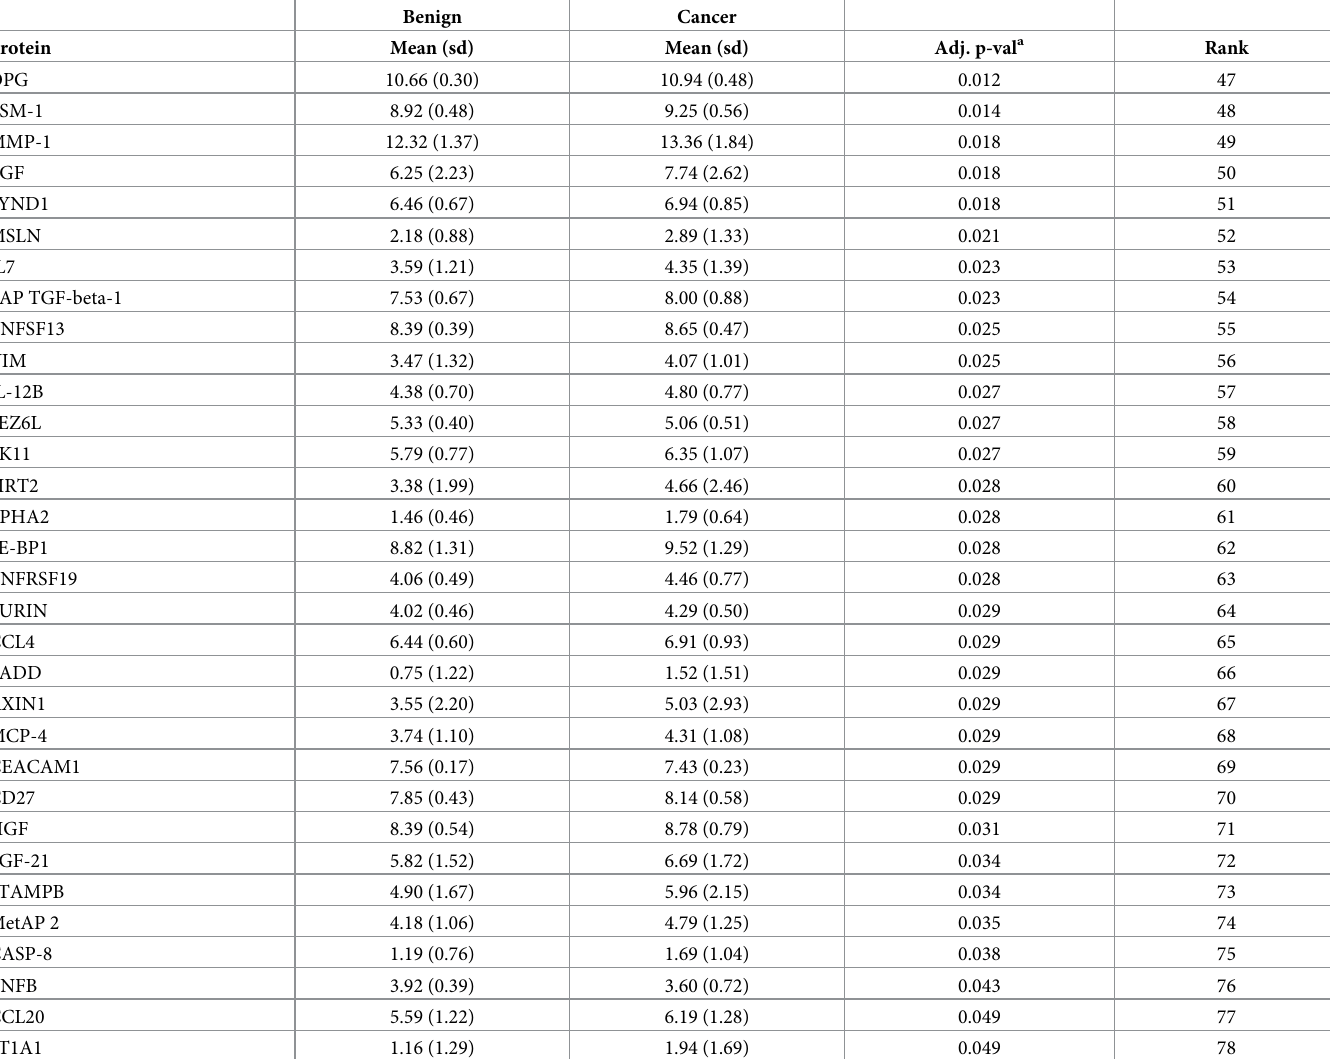
Benign tumors vs. borderline + cancer A statistically significant difference in NPX levels between benign tumors and borderline tumors + cancer was found for only two proteins, HE4 (WFDC2) and CA125 (MUC16) (conservative cut-off p < 0.001, p-values adjusted with False Discovery Rate (FDR)) (Table 6). Box plots for the six proteins with the lowest p-values are shown in S4 Fig. Table 7 shows the AUC values for discriminating benign tumors from borderline tumors + cancer for the individual proteins. Fifteen proteins had AUC > 0.7. HE4 (WFDC2) ranked highest with AUC 0.767 (0.672–0.861). ROC curves for the six proteins with the highest AUC values are depicted in Fig 3. Table 8 shows the AUC values, sensitivities and specificities for the reference model with HE4, CA125 and age (AUC 0.770